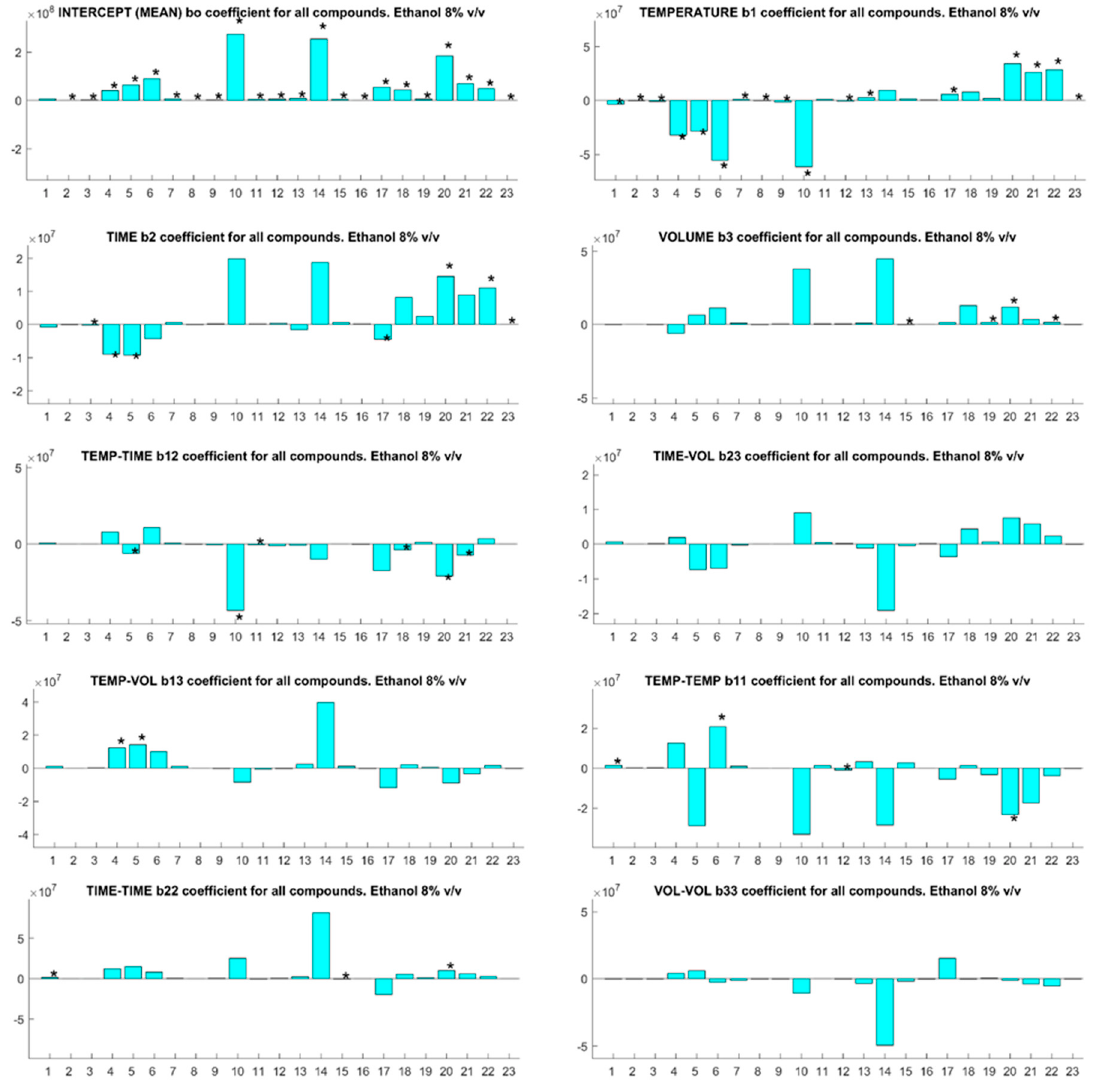
Figure 2. The b -coefficients (absolute units) for SPME optimization parameters for 23 compounds with an ethanol concentration of 8% v / v . Significant coefficients for compounds are indicated with an asterisk (*). Compound identification is cross-referenced to the numbered compounds in Table 1.